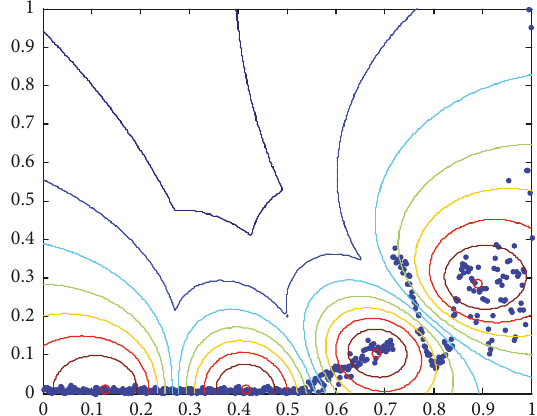
Figure 9: The clustering result of the ADF proposed by fuzzy C-means.